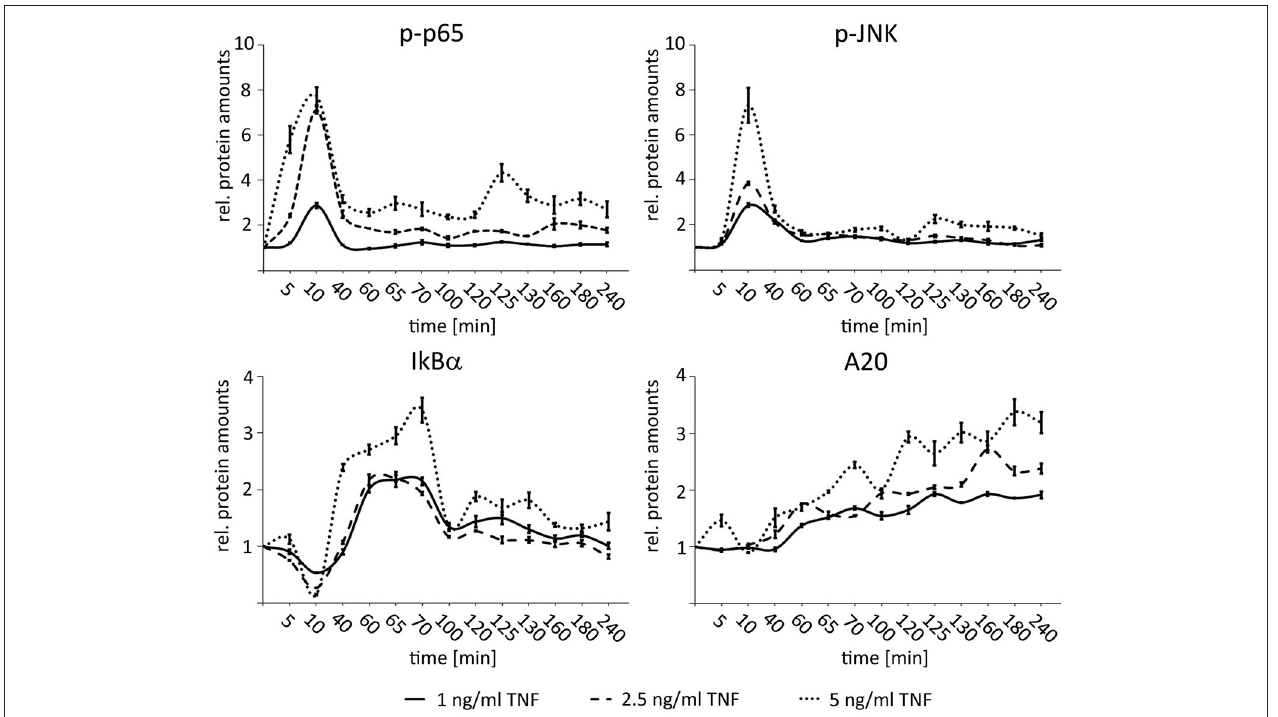
FIGURE 3 | Dose-dependent activation of NF- κ B and JNK signaling after TNF stimulation in HCC cells. Graphs summarizing the results of Western immunoblots analysis after treatment of Hepa1-6 cells with TNF (1, 2.5, and 5 ng/ml) for the indicated time-points (untreated and 5–240 min after stimulation). Signals for phospho-p65, phospho-JNK, I κ B α , and A20 were quantified and normalized to the respective loading control (actin). Graphs summarize the results from three independent analyses. Bars represent standard